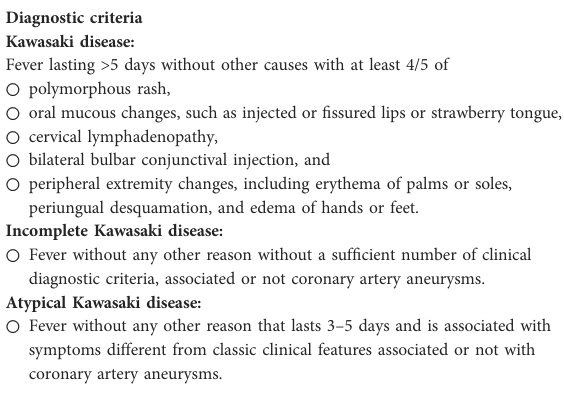
TABLE 1 Diagnostic criteria for KD, incomplete Kawasaki disease (IKD), and atypical Kawasaki disease (AKD) (3, 5). Diagnostic criteria Kawasaki